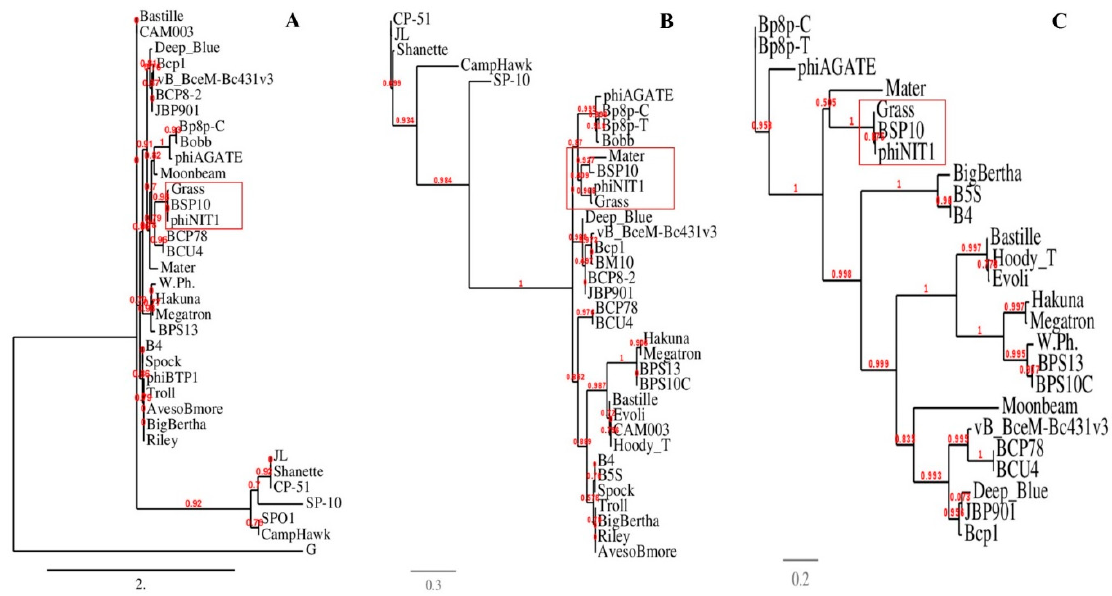
Figure 4. Phylogenetic analysis of the major capsid proteins ( A ), terminase large subunit ( B ), and metallophosphatases ( C ) of ICTV-classified Bacillus bacteriophages. The tree was constructed using “one click” within the phylogeny.fr program. The approximate likelihood ratios for individual branches are shown in numbers.